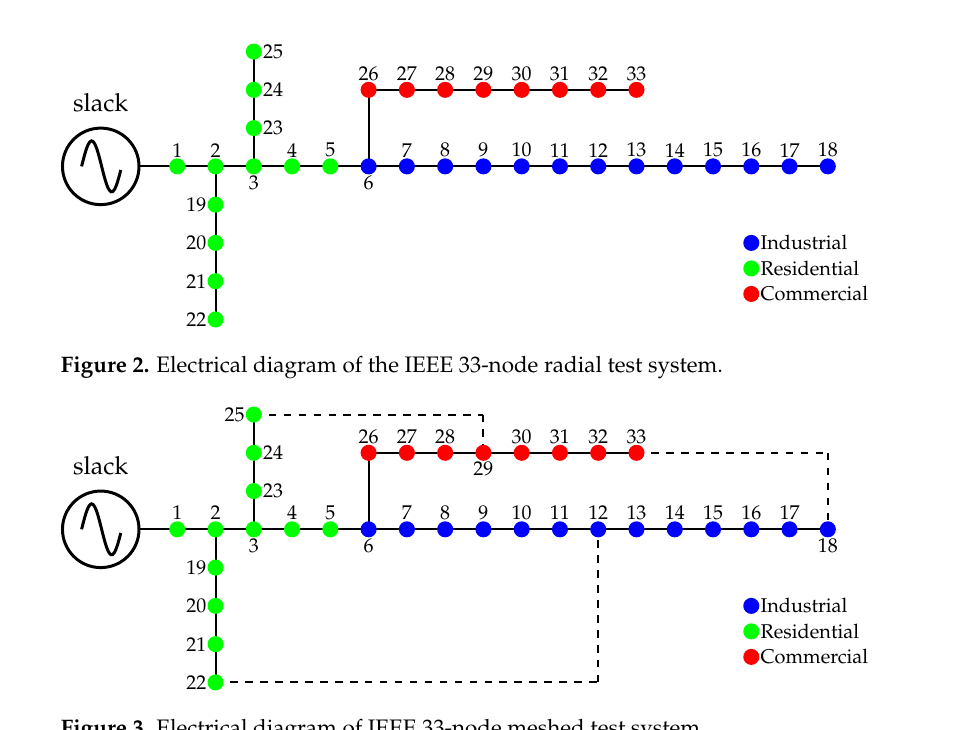
Figure 3. Electrical diagram of IEEE 33-node meshed test system.